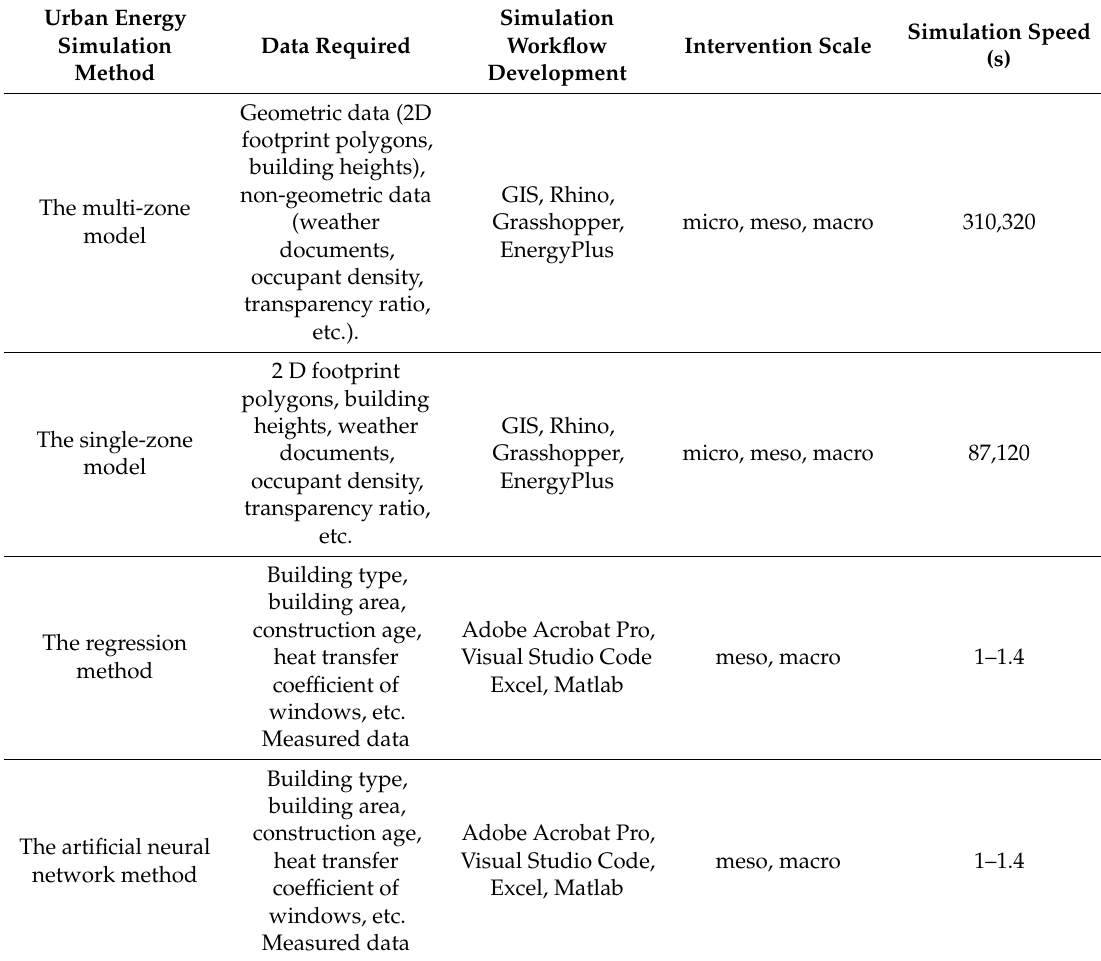
Table 6. Comparison of simulation performance of urban energy consumption simulation